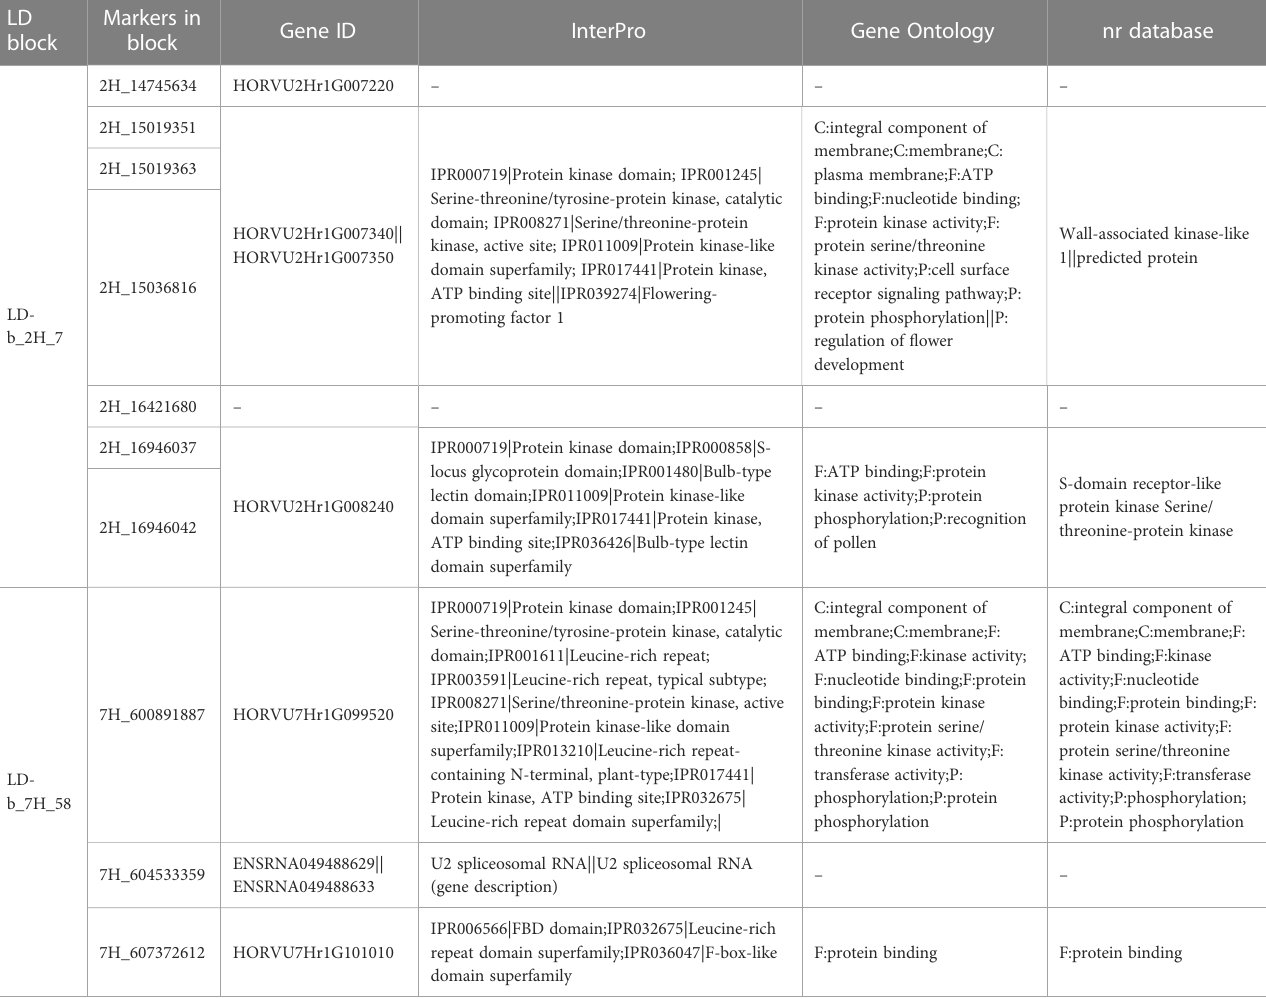
TABLE 8 Selected gene annotations for LD blocks linked concurrently to root- and yield-related traits. LD block